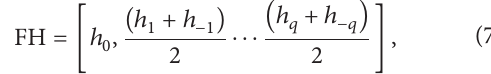
the vertical direction. (3) For the differences created by other kernels shown in “ Multidirectional Kernel Groups G(1)–G(3) ,” the AR coefficients are first extracted from the horizontal and vertical direction, respectively, and FAR are then obtained by averaging